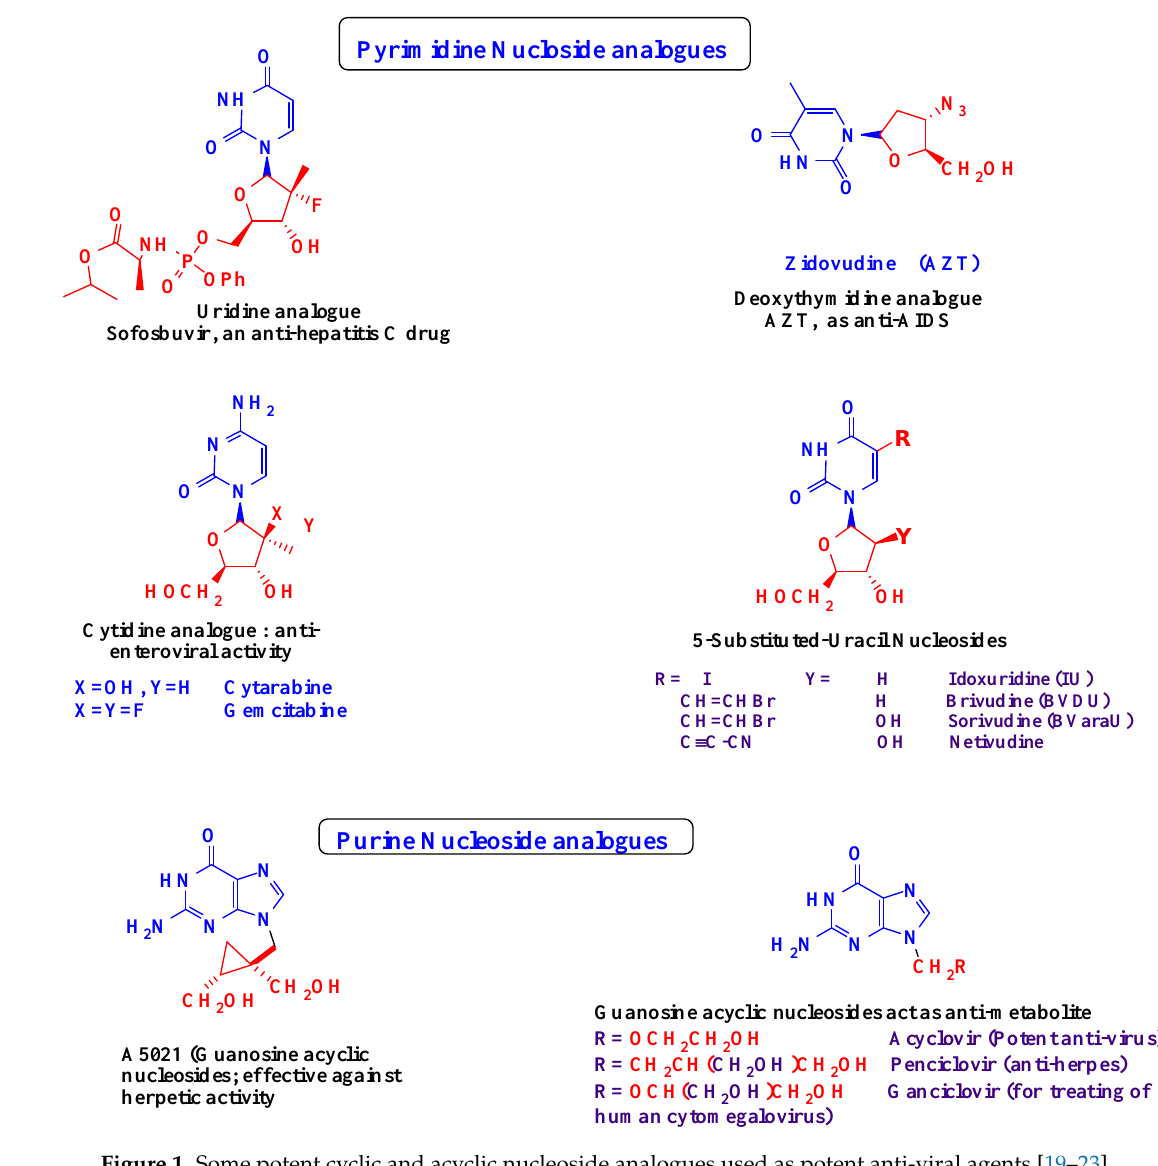
Figure 1. Some potent cyclic and acyclic nucleoside analogues used as potent anti-viral agents [19–23].